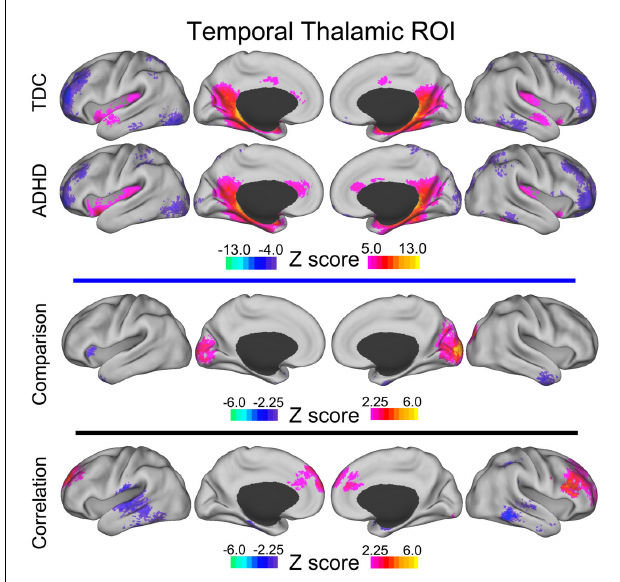
FIGUREA6 |Temporal thalamic voxelwise maps projected onto cortical surfaces. Each row displays the cortical surface for each voxelwise map generated from the temporal thalamic ROI: group maps forTDC, group maps for ADHD-C, maps from the comparative analysis (TDC vs. ADHD-C), and maps from the correlation analysis. Cortical surface projection was performed with the (PALS)-B12 atlas (Van Essen, 2005) and the software Caret (Van Essen et al.,